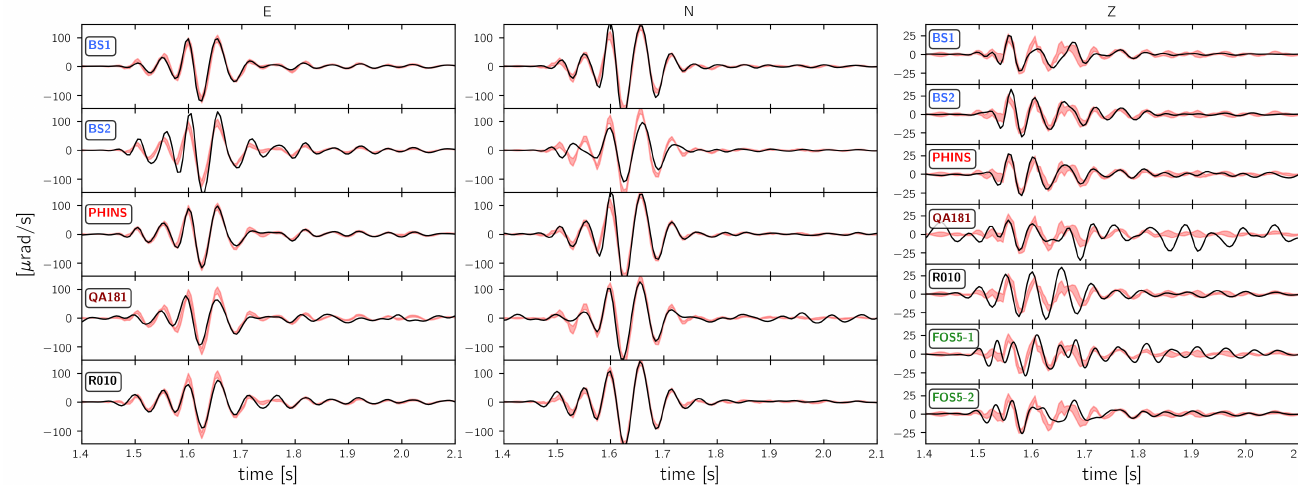
Figure 12. 30Hz low pass filtered waveforms from “expl2” (see Figure 1) recorded by instruments that were placed on top of the monument. The red shaded region depicts the median over all waveform and it has a width of one standard